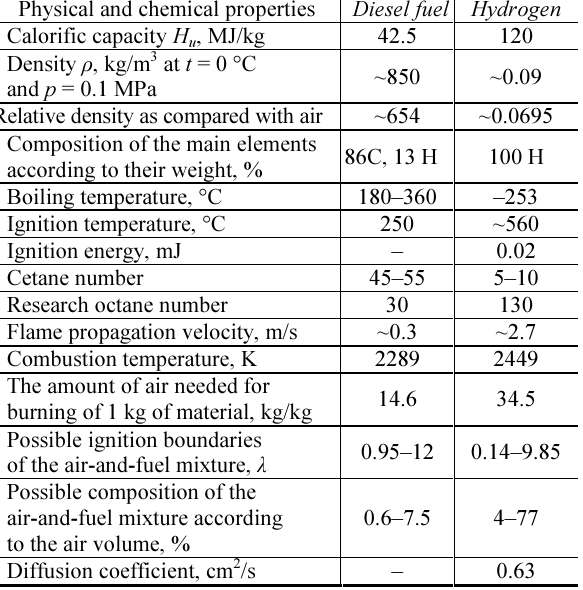
Table 1. Physical and chemical properties of diesel fuel